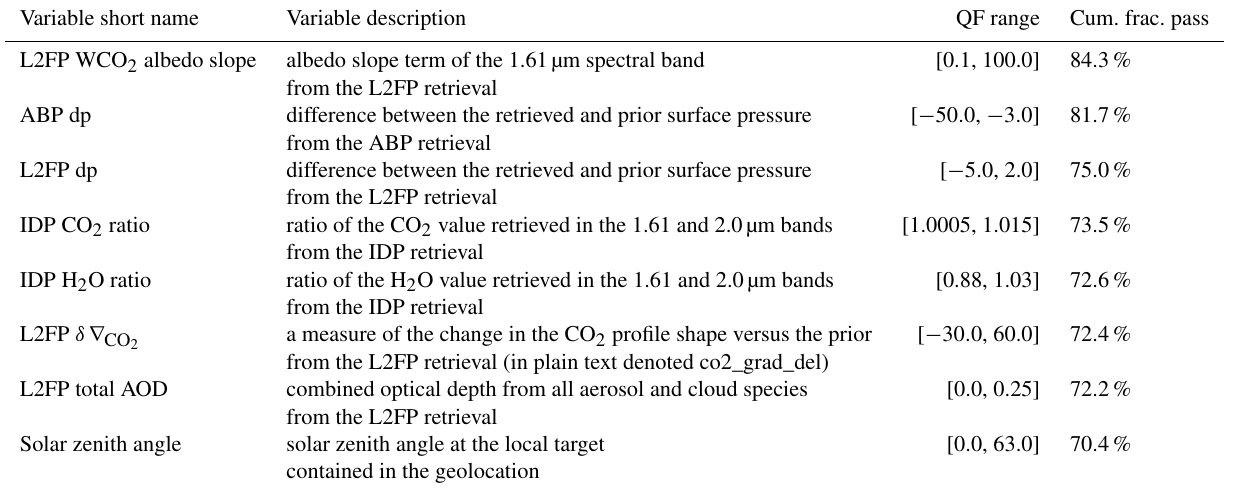
Table 3. Same as Table 2, but for glint–water